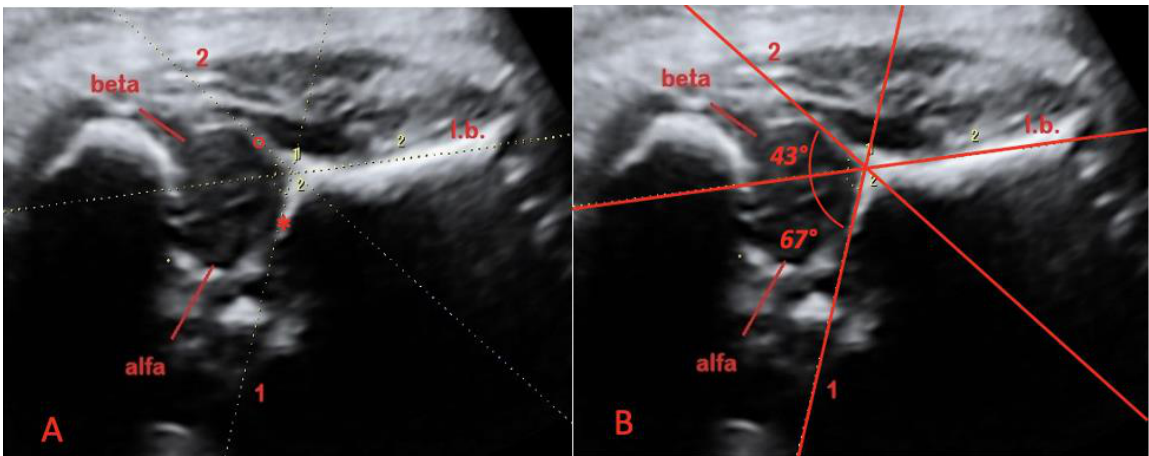
Figure 1. ( A ) Midsagittal plane of the coxofemoral joint, obtained with 3D ultrasound, in a fetus at 37 weeks of gestation: the “Y” sign. The iliac bone (I.b.), the labrum acetabular (°) and the lower edge of ossified ilium (*). ( B ) Midsagittal plane of coxofemoral joint, obtained with 3D ultrasound, in a fetus at 37 weeks of gestation: the “Y” sign. The alpha angle (“bone angle”) is the angle formed by a line tangential to the horizontal iliac wing (I.b.) and a line tangential to bone roof (*). The beta angle (“cartilage angle”) is the angle formed by a line tangential to the horizontal iliac wing (I.b.) and a line tangential to cartilaginous roof (°).